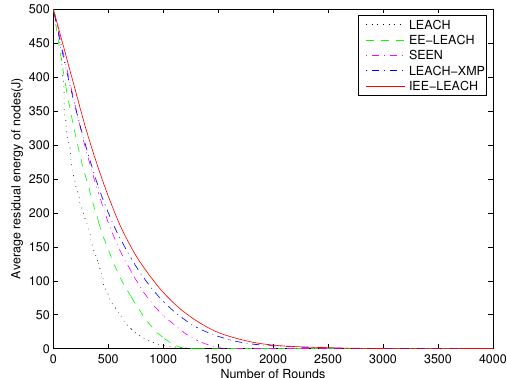
Figure 13. Comparison of residual energy of nodes for a large sensor field.